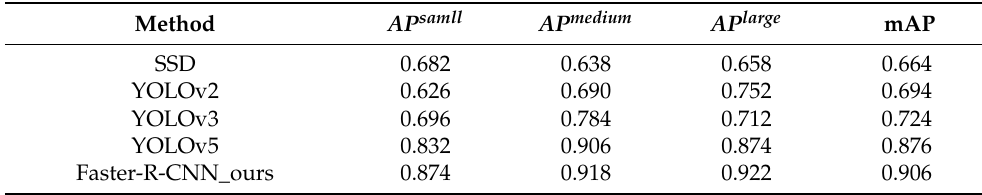
Table 5. Results of the comparative experiments at sunset.